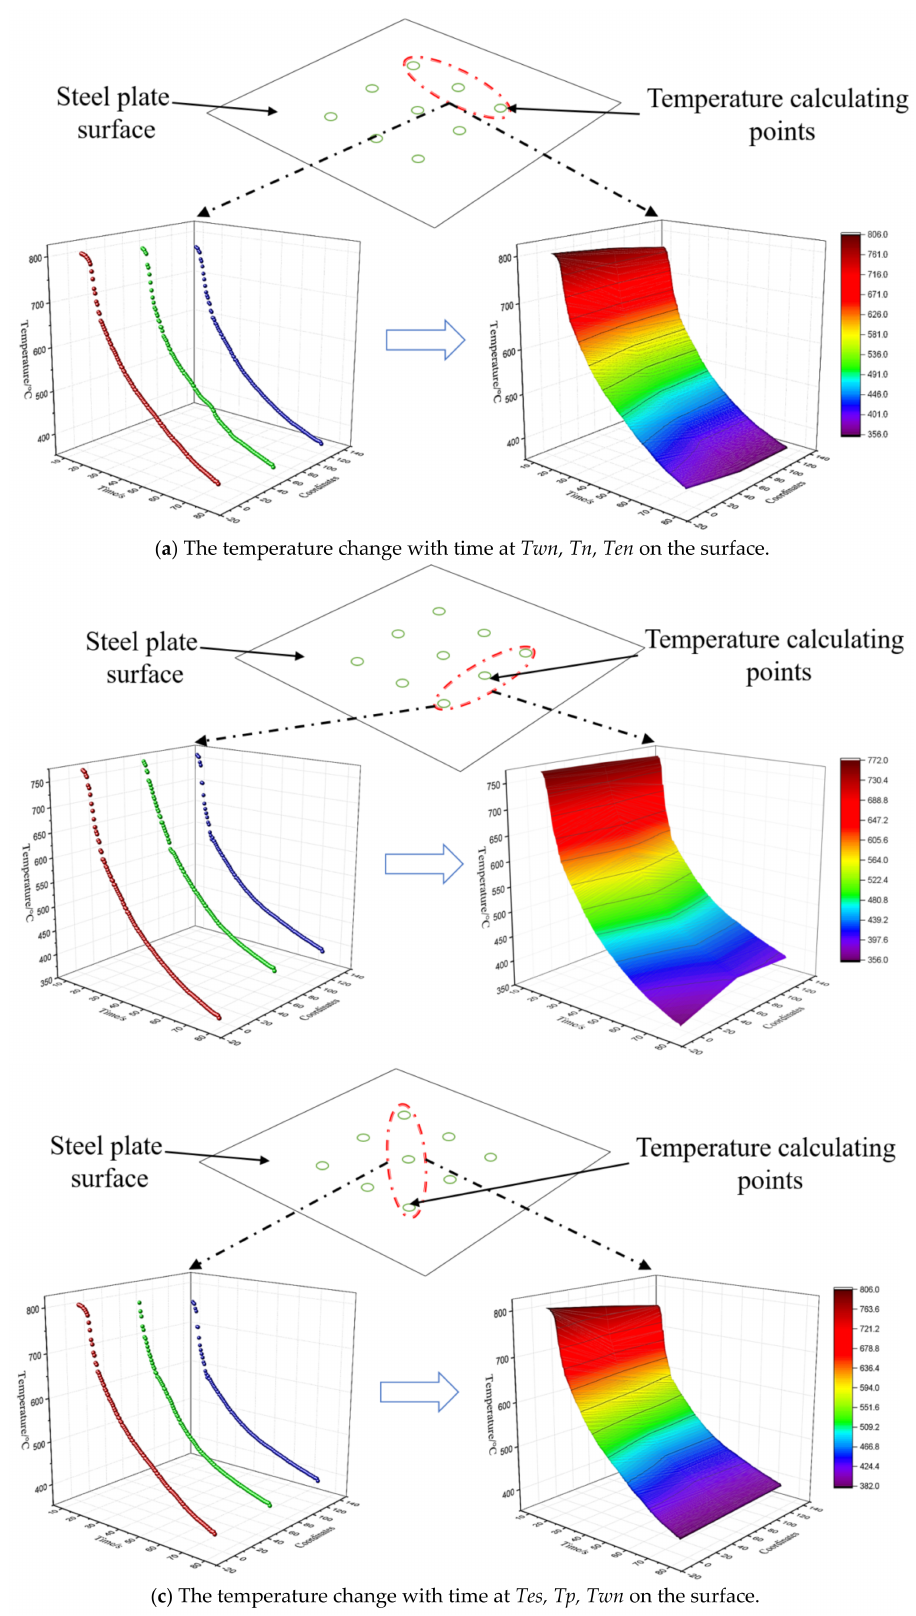
Figure 7. The temperature change with time at different points on the